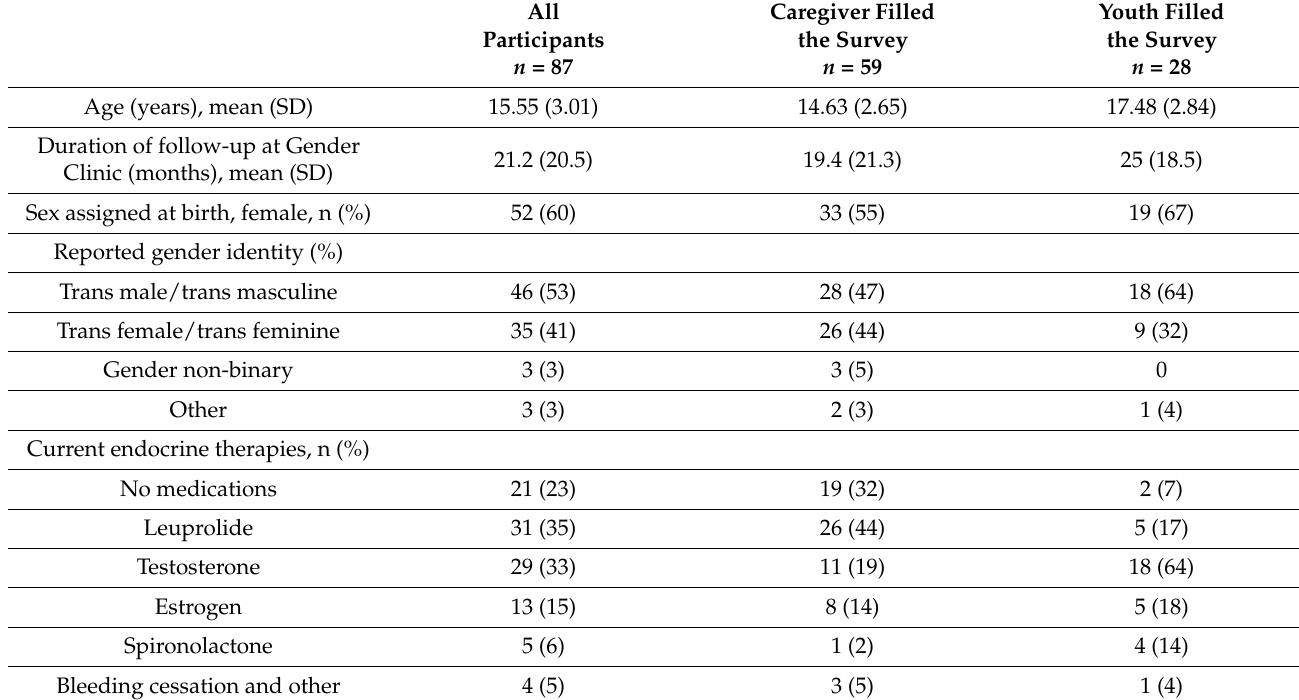
Table 1. Characteristics of trans youth participating in virtual gender visits.